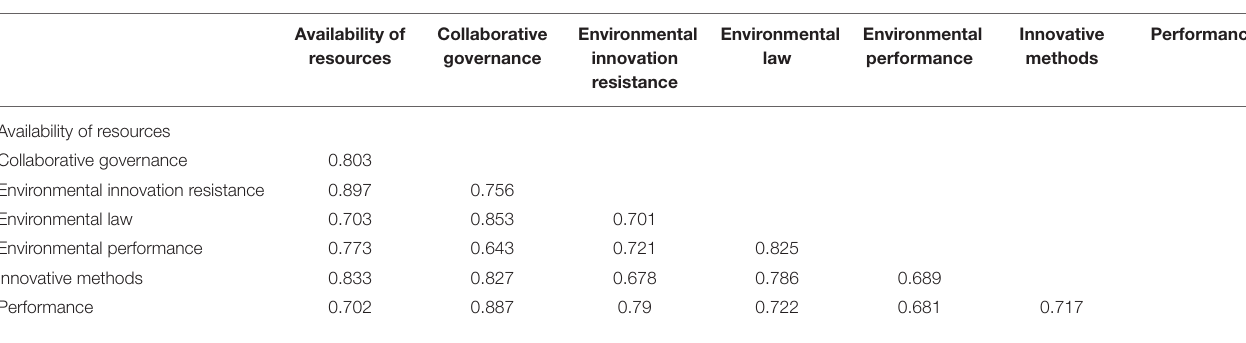
TABLE 3 | Discriminant